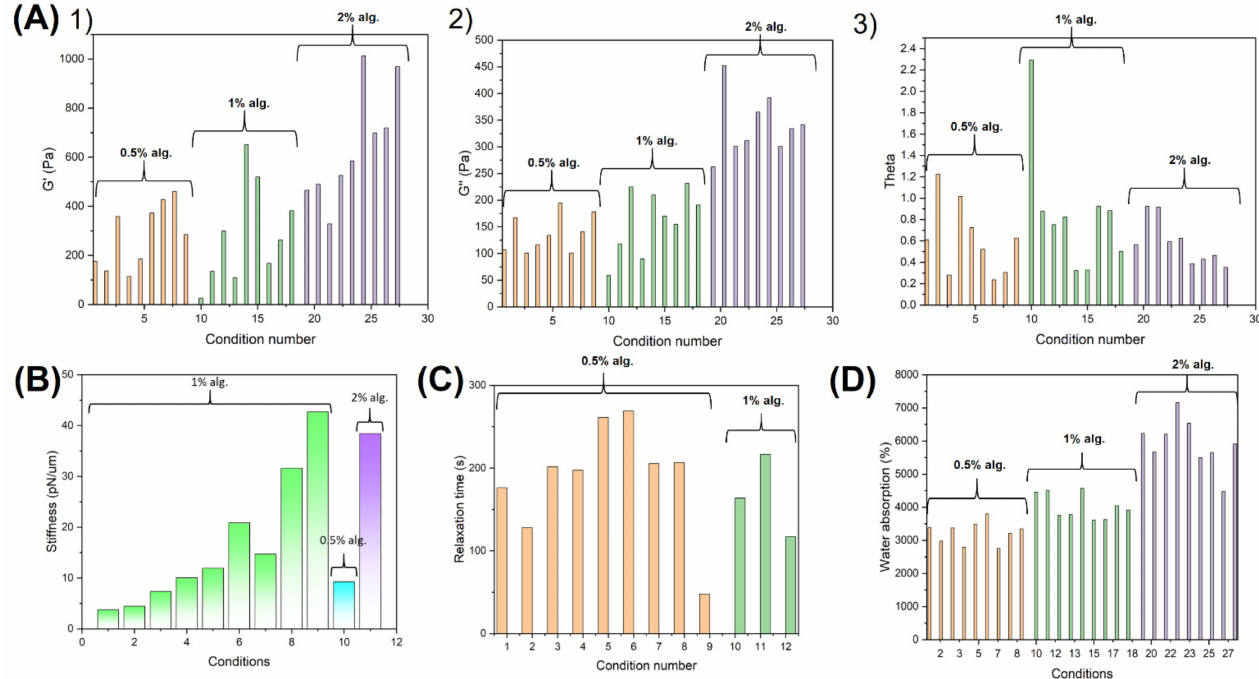
Figure 3. Adjustable mechanical properties of alginate–gelatin hydrogel: ( A ) viscoelasticity